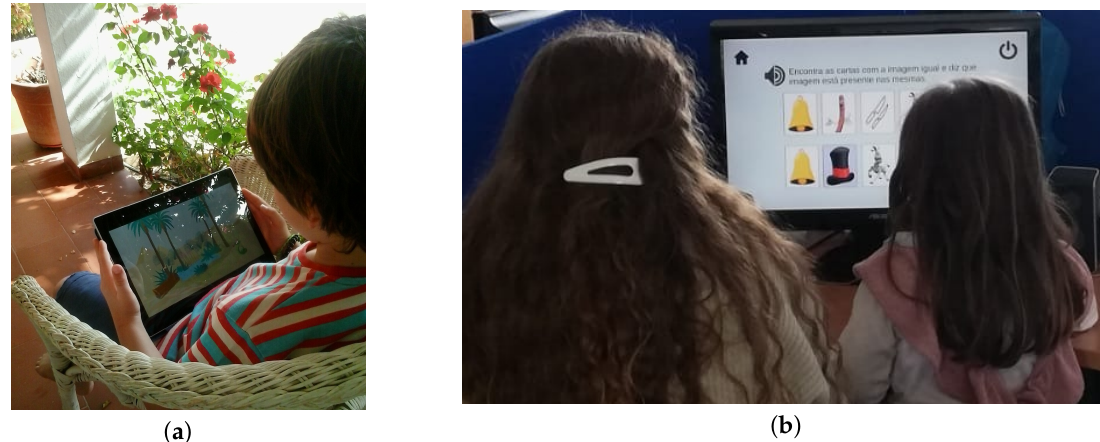
Figure 4. The BioVisualSpeech games for sigmatism. ( a ) Child playing the isolated sibilants game. ( b ) Child playing the pairs game with the help of an adult.